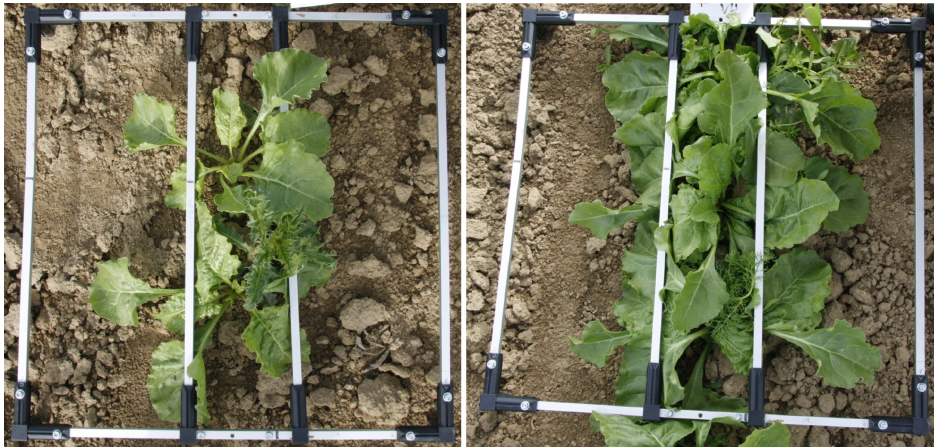
Figure 6. Intrarow weeds C. arvense ( left ), M. inodora ( right ), and G. aparine ( right